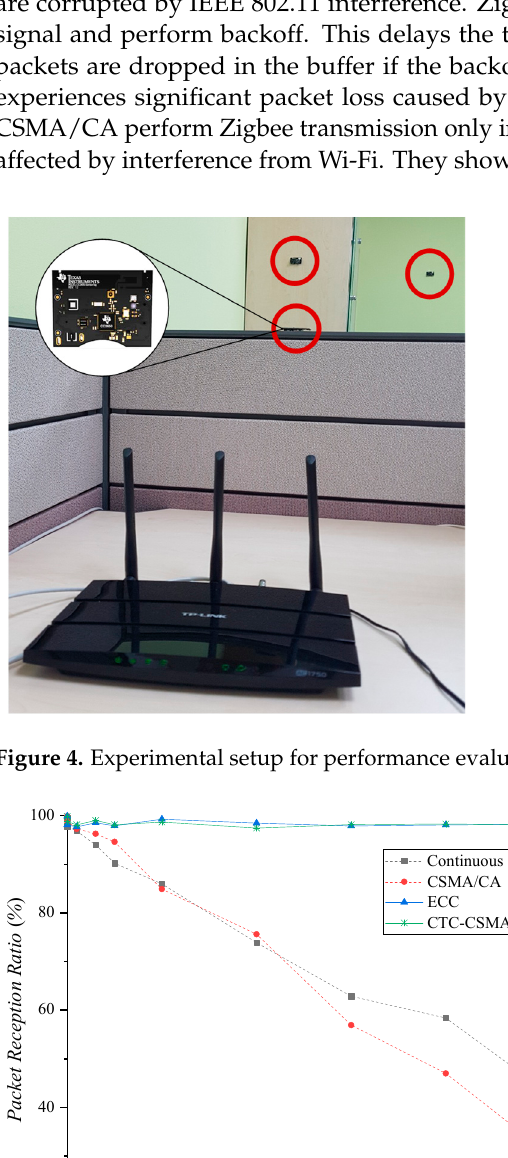
Figure 6. CTC-RTS success ratio according to Wi − Fi traffic load. 4.2. Interference-Free Period Allocation ECC and CTC-CSMA/CA secure an interference-free period via white space alloca- tion. Assuming that a fixed volume of Wi-Fi traffic occurs randomly in a fixed period, we first examine the white space distribution of ECC. Figure 7 shows the cumulative distri- bution of white space determined by ECC with different Wi-Fi traffic loads. When the Wi-